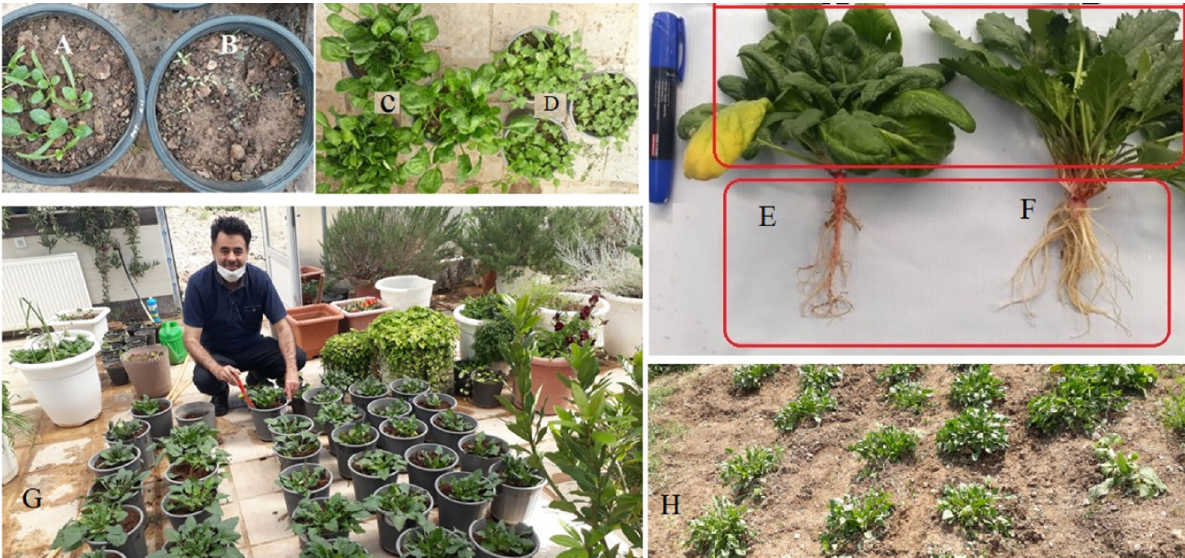
Figure 2. Seedlings of two studied plants [( A ) cultivated spinach, ( B ) wild spinach] and greenhouse experiments [( C ) cultivated spinach, ( D ) wild spinach]. Morphological characteristics of complete plants [( E ) cultivated spinach and ( F ) domesticated spinach]. Some agronomical practices on domesticated spinach ( G ), and field culture of selected spinach for the start of mass selection program ( H ). The person in G is Ali Ammarellou, author and researcher of this